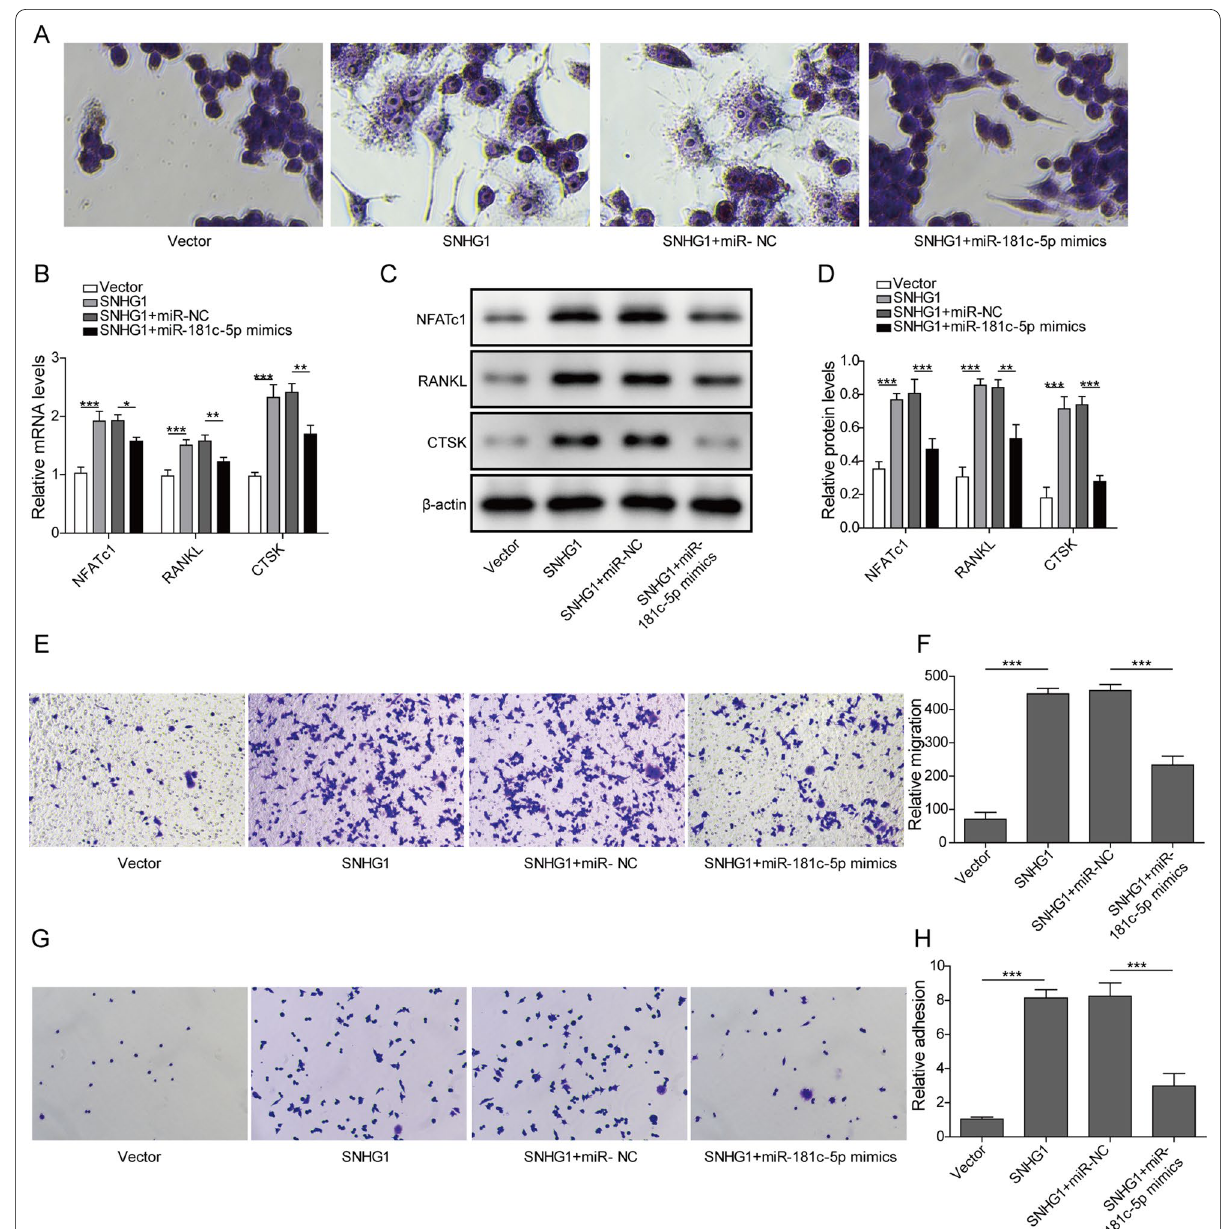
Fig. 4 LncRNA SNHG1 overexpression promoted osteoclast differentiation by targeting miR‑181c‑5p. The BMSCs were transfected by vector‑NC, SNHG1 vector, SNHG1 vector with miR‑NC, or SNHG1 vector with miR‑181c‑5p mimics, and induced with M‑CSF and RANKL for 10 days. A Representative images of TRAP staining in four groups. B–D After induction, the mRNA and protein expression of NFATc1, RANKL and CTSK in BMSCs were measured through qPCR and western blot. E and F Cell migration of treated BMSCs was determined using Transwell assay. G–H Adhered cells were stained with crystal violet and cell number was counted. * P < 0.05, ** P < 0.01, *** P <